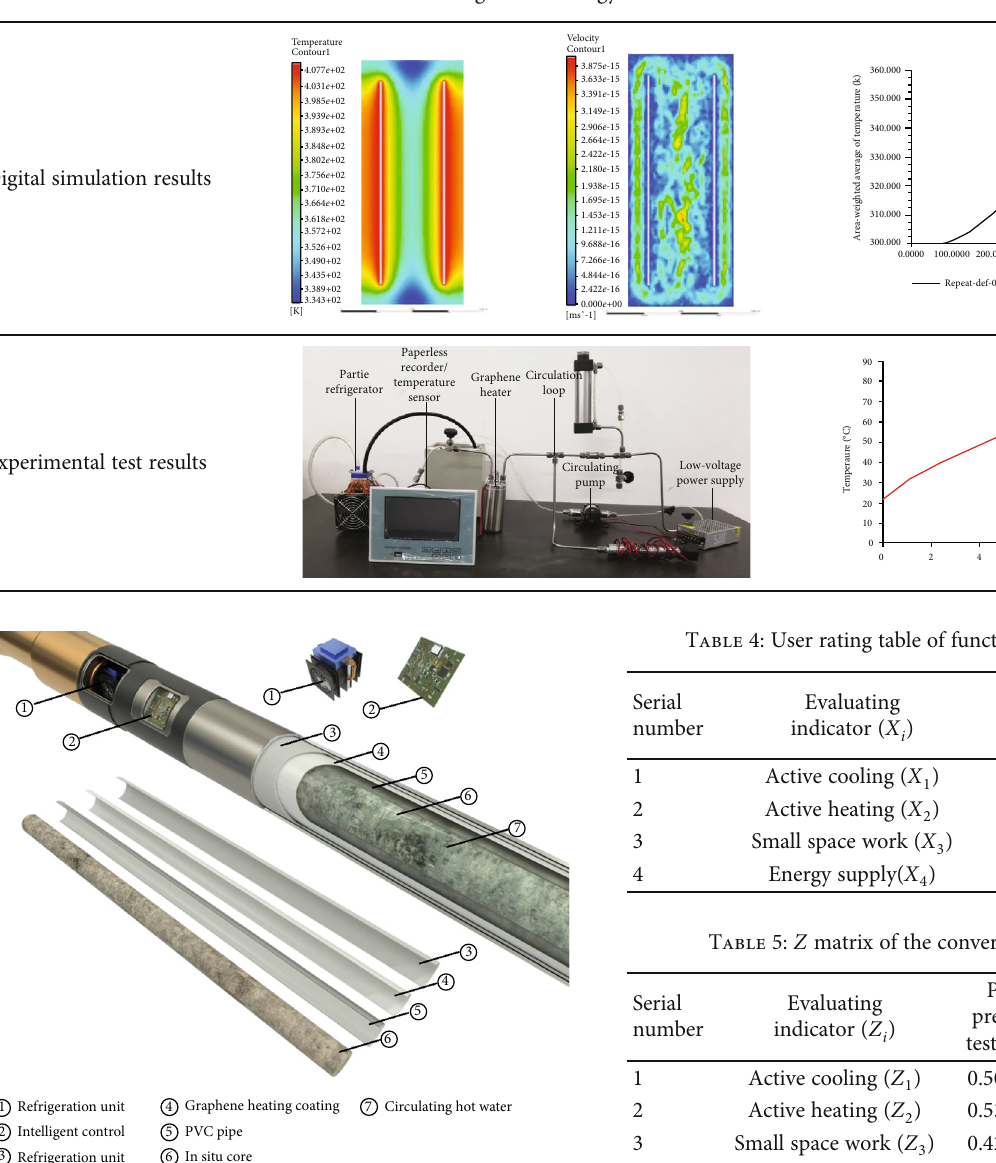
Table 3: Digital technology and test results contrast.